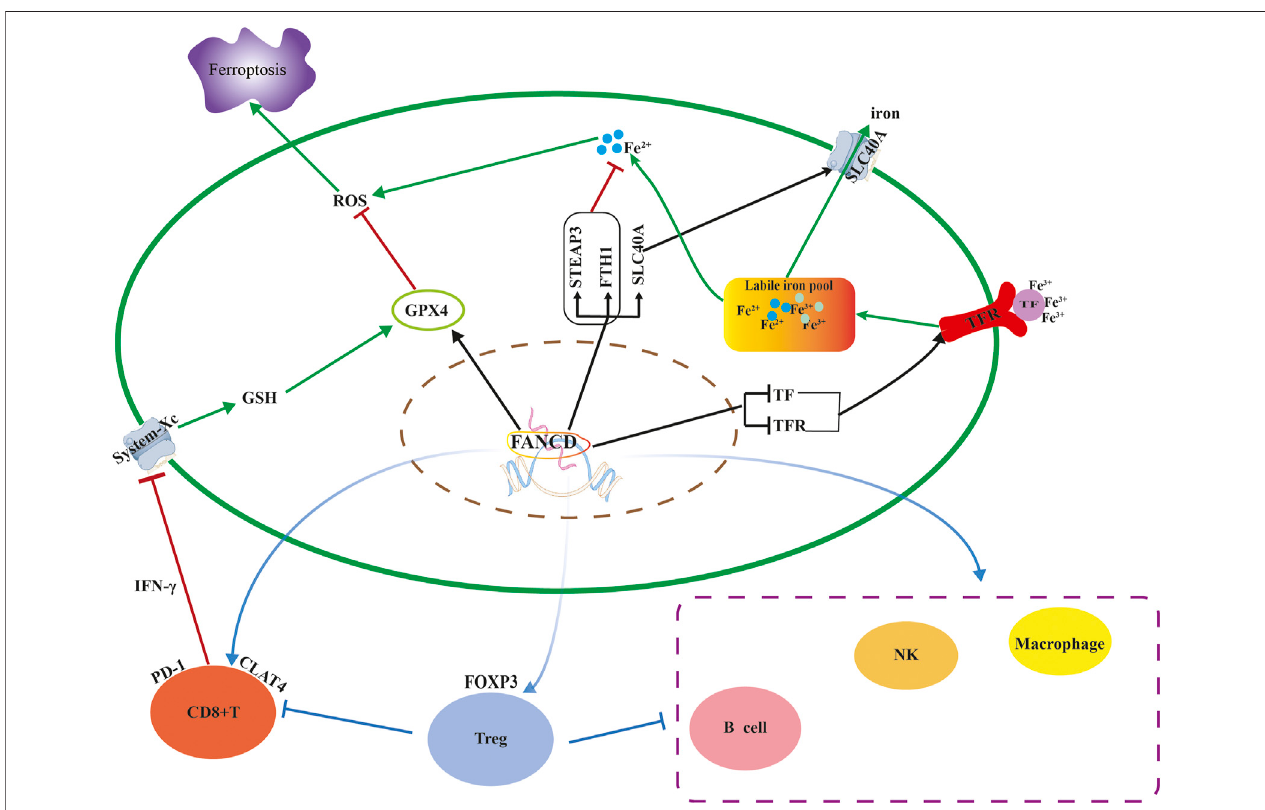
FIGURE 10 | The mechanism of FANCD2 regulating ferroptosis and immune cell in fi